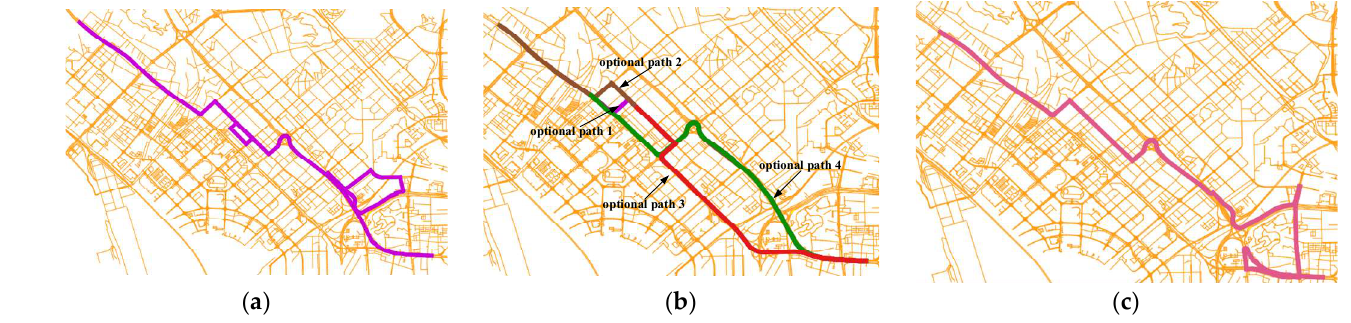
Figure 15. Comparison of matched paths of HTMM and ST-Matching: ( a ) sampling rate of 30 s (real path); ( b ) sampling rate of 60–300 s (ST-Matching); ( c ) sampling rate of 60–120 s (HTMM).